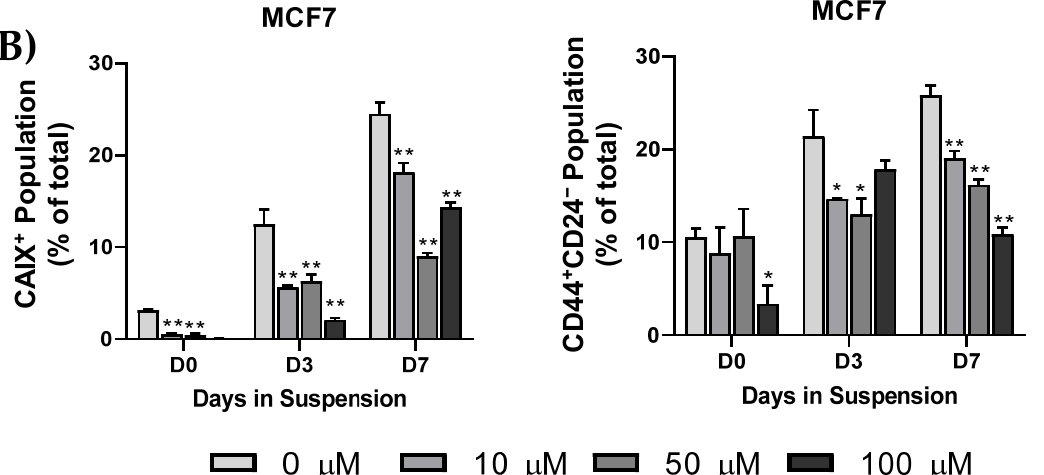
Figure 5. The cBCSC and CAIX populations are inhibited following treatment with U-104 under suspension. ( A ) MB-231 and ( B ) MCF7 cells were cultured in a monolayer (D0) or suspension condition for 3 or 7 days and then treated with 0, 10, 50, or 100 µ M of U-104 for 24 h. Treated cells were then analyzed for CD44, CD24, and CAIX surface expression using MIFC. The CAIX + and the CD44 + CD24 − decreased in a dose-dependent manner with U-104 treatment. (n = 3, * p < 0.05, ** p < 0.01).